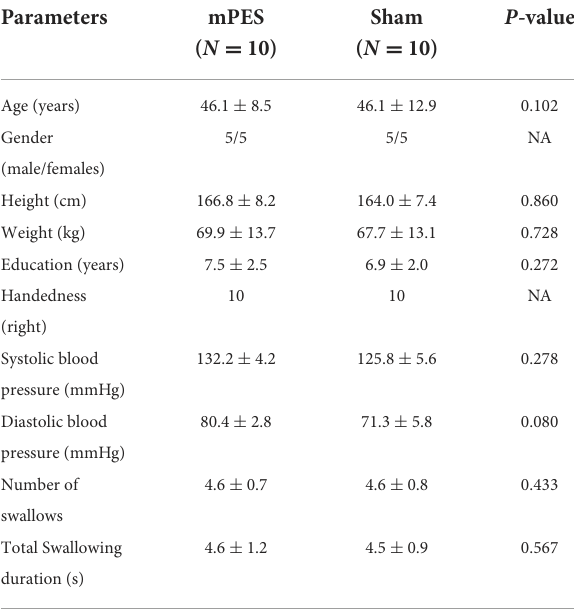
TABLE 1 The basic demographic information of the 20